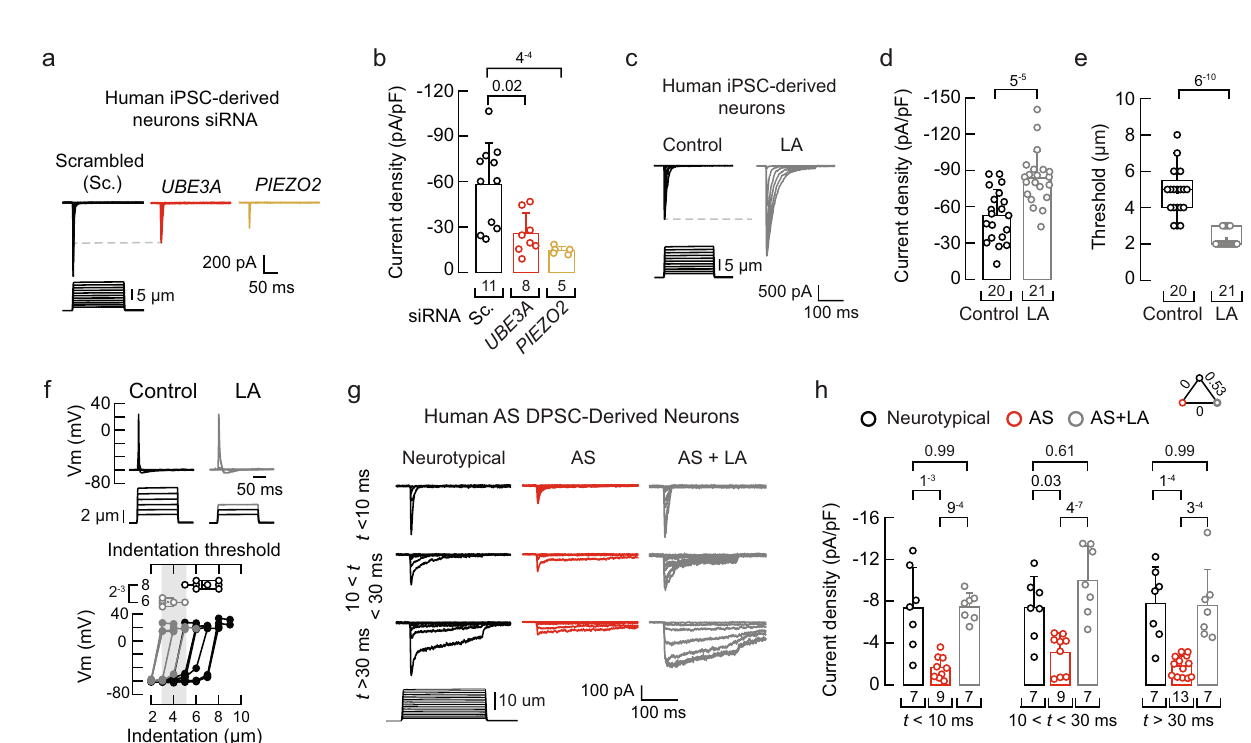
Fig. 9 | Loss of UBE3A expression decreases PIEZO2function in human-derived neurons. a Representative whole-cell patch-clamp recordings of currents elicited by mechanical stimulation ( − 60 mV) in human iPSC-derived sensory neurons transfected with scrambled, UBE3A , or PIEZO2 siRNAs. b Current densities elicited by maximum displacement of siRNA-transfected iPSC-derived neurons. Bars are mean±SD. Kruskal-Wallis (H=13.9; p =9.6 − 4 ) and Dunn ’ s multiple comparisons test. c Representative whole-cell patch-clamp recordings of currents elicited by mechanical stimulation ( − 60 mV) of control and LA-treated iPSC-derived sensory neurons (two-day LA supplementation; 50 µ M for 24h and 100 µ M for another 24h). d Current densities elicited by maximum displacement of control and LA- treated iPSC-derived neurons. Bars are mean±SD. Two-tailed unpaired t -test ( t =4.57). e Boxplots show the displacement thresholds required to elicit mechanocurrents in of control and LA-treated iPSC-derived neurons. Two-tailed Mann-Whitneytest(U=9). f Top,current-clamprecordingsofmembranepotential changes elicited by indentation of control and LA-treated iPSC-derived neurons. Bottom,membranepotentialpeak vs .mechanicalindentationofindependentiPSC-